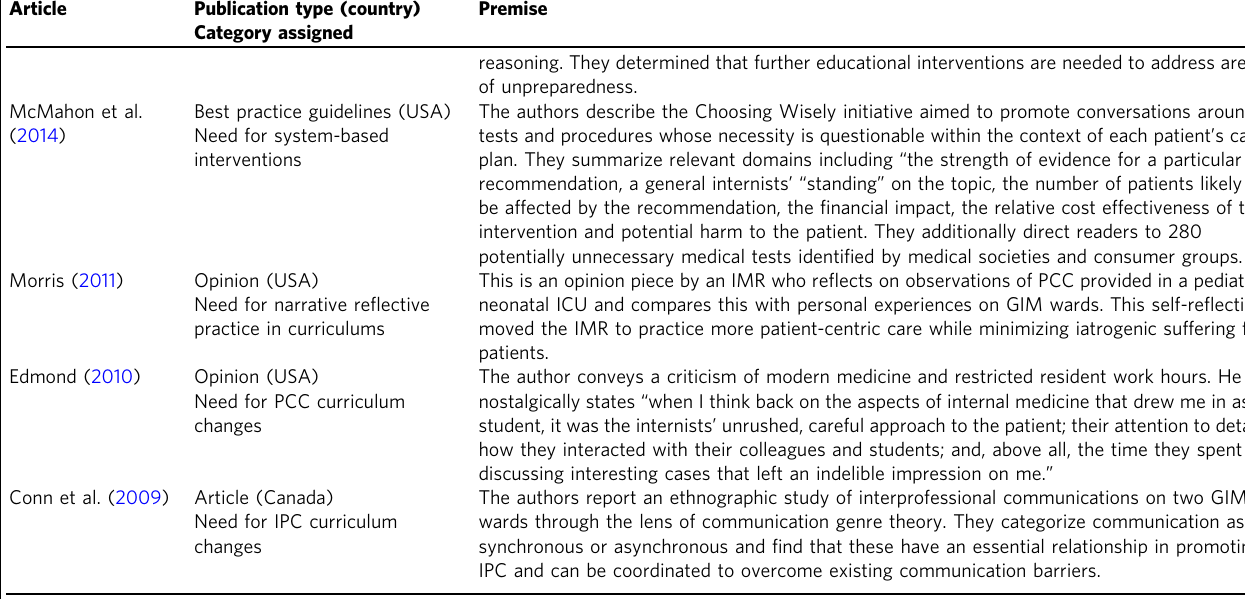
Table 3, learners must attend to the patient ’ s narrative and environment, not as an afterthought, but as part of the clinical reasoning process (Kathol and Kathol,